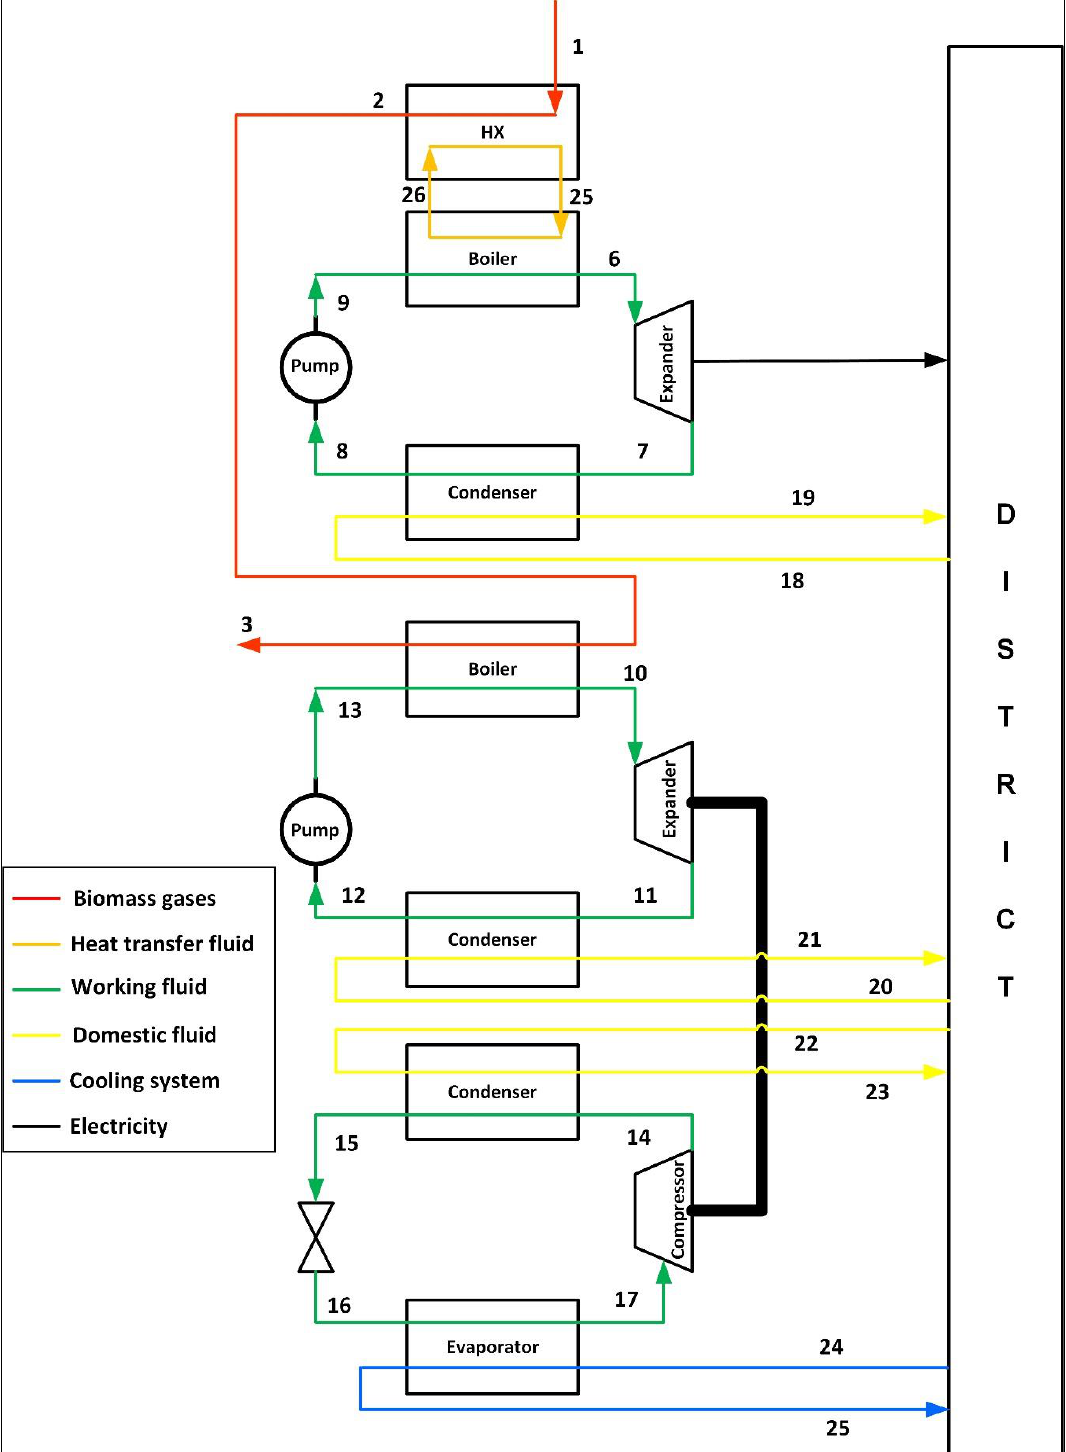
Figure 1. Schematic of the proposed biomass hybrid trigeneration system.